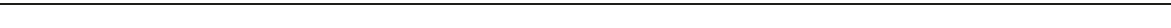
Fig. 7 TFEB/3 and SREBF2 co-operate to regulate TMEM55B levels in response to changes in cholesterol levels. a , b HeLa cells were treated with drugs to deplete cellular cholesterol for 120 h, treated with 10 μ M U18666A for 18 h, or left untreated. a Relative quantitative real-time PCR analysis of TMEM55B mRNA transcript levels (mean ± s.e.m. of the RNA fold change of indicated TMEM55B normalized to GAPDH mRNA, using two-tailed t-test ** P < 0.005 were considered signi fi cant) n = 3. b Representative immunoblot of lysates from cholesterol depleted cells. c Control MEFs were untreated or incubated